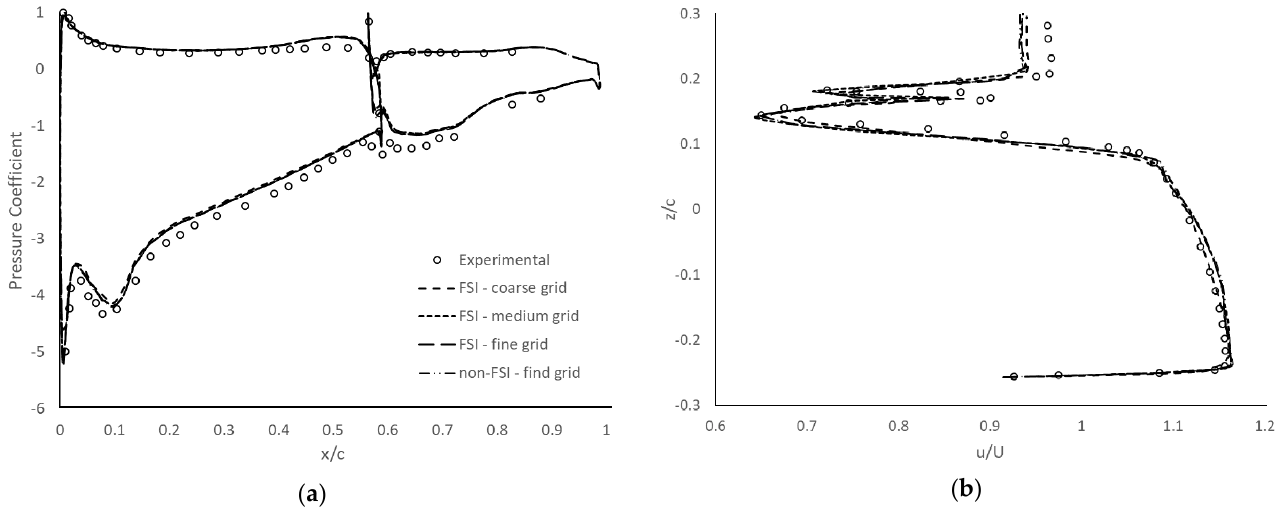
Figure 4. Grid sensitivity effect: ( a ) surface pressure distribution, ( b ) wake profile at x/c = 1.066.